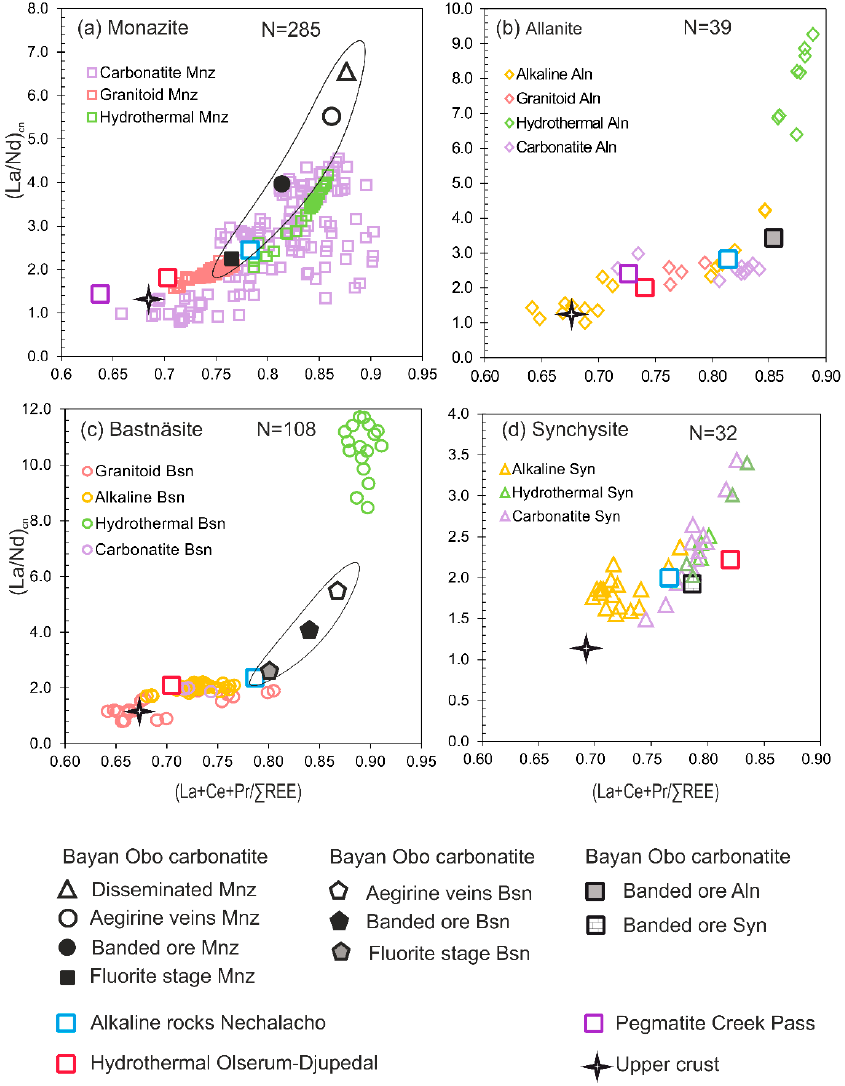
Figure 22. Composition plots showing (La/Nd) cn ratios against (La + Ce + Pr/ Σ REE) ratios in the studied REE minerals of different origin in Finland and the averages of these ratios from REE deposits outside of Finland. Sources of data for deposits outside of Finland are referred in the text. The average upper crust data are from [71]. ( a ) Monazite, the fractionation trend observed by [3] at Bayan Obo is highlighted by the black ellipse. ( b ) Allanite, ( c ) Bastnäsite, The fractionation trend observed by [3] at Bayan Obo is highlighted by the black ellipse. ( d ) Synchysite.